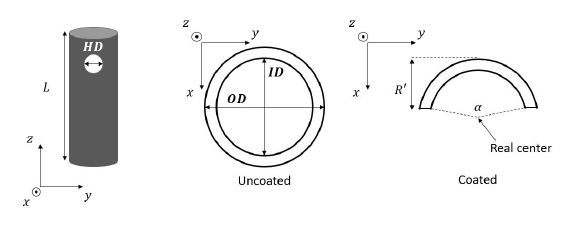
Figure 2. Schematics of two geometries of samples used. Uncoated samples have cylindrical geometry. Coated samples are almost half cylinder. R’ is mea- sured to determine the α parameter in order to calcu- late the accurate surface of coated